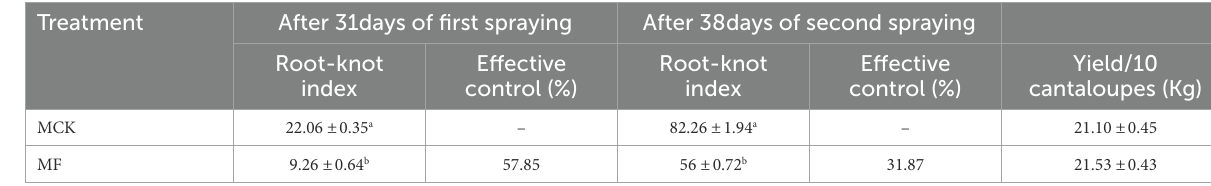
TABLE 1 The efficacy of nematicide (fosthiazate 40%) after 31 and 38 days of first and second spraying, respectively against the meloidogyne and yield of Cucumis melo var. saccharinus